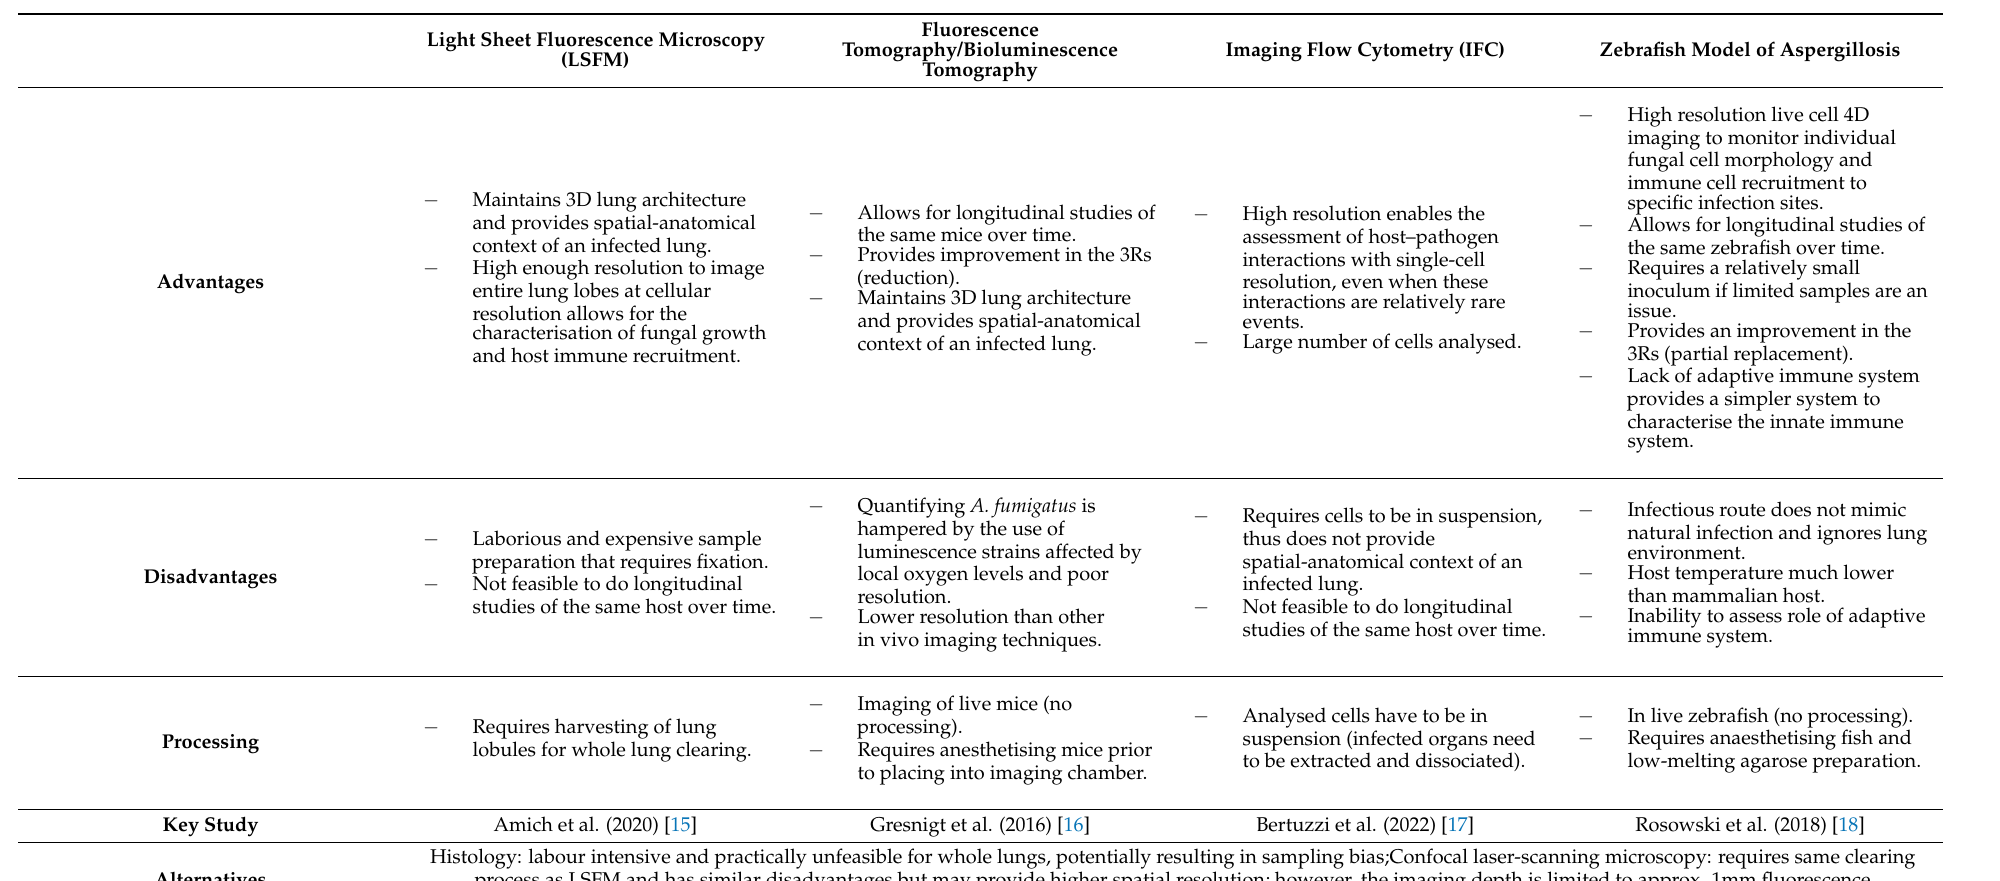
Table 1. Summary of advantages and disadvantages associated with different in vivo imaging techniques discussed in this